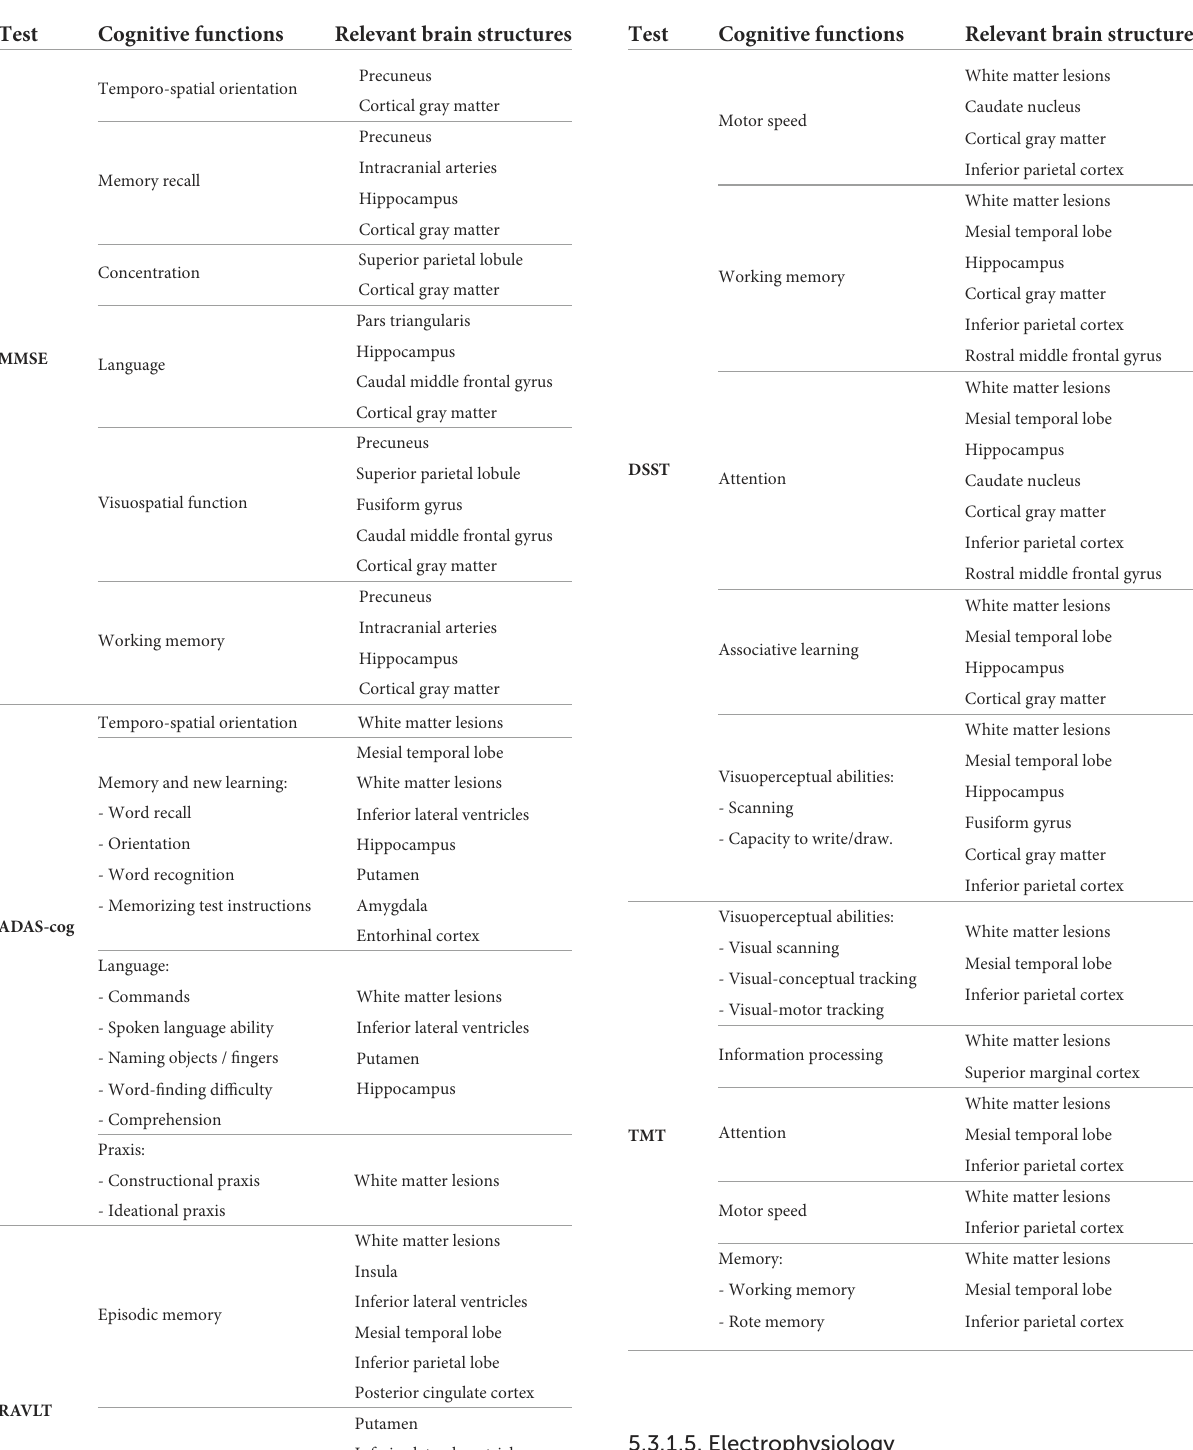
TABLE 5 Structural brain correlates and cognitive functions involved in MMSE, ADAS-cog, and RAVLT.